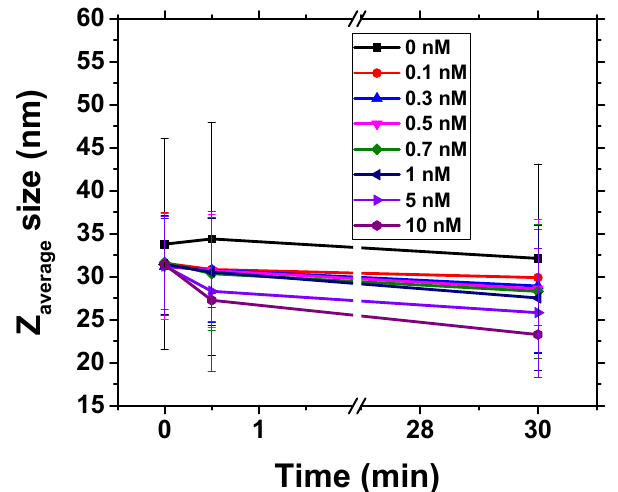
Figure 7. Change in Z-average size of AuNPs modified by β -casein at time 0 and 30 min at presence of various concentrations of chymotrypsin (see the insert). The results represent mean ±SD obtained from 3 independent measurements at each concentration of chymotrypsin.